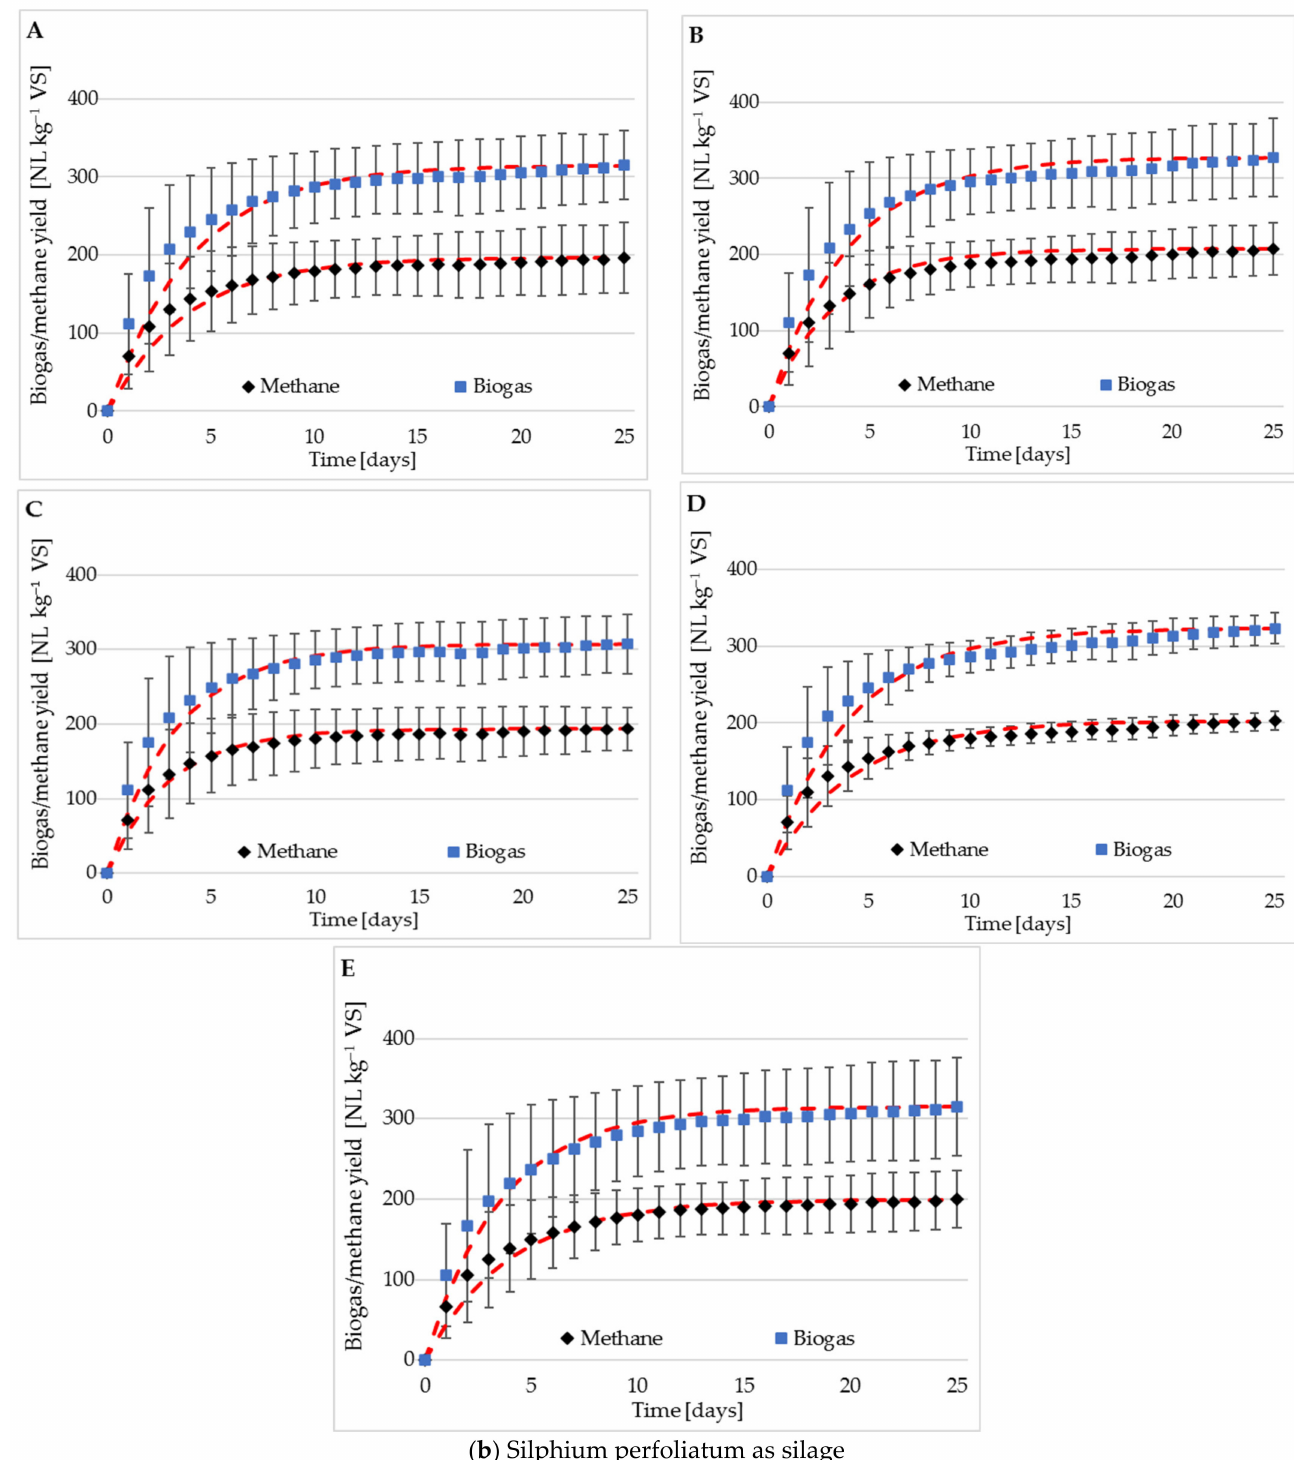
Figure 2. Cumulative methane and biogas yield (NL kg − 1 VS) of Silphium perfoliatum as raw biomass ( a ) and as silage ( b ) in the 25-day test, depending on the type of fertilization (kg ha − 1 N): ( A ) mineral fertilization 85, ( B ) mineral fertilization 170, ( C ) organic fertilization 85, ( D ) organic fertilization 170, ( E ) without